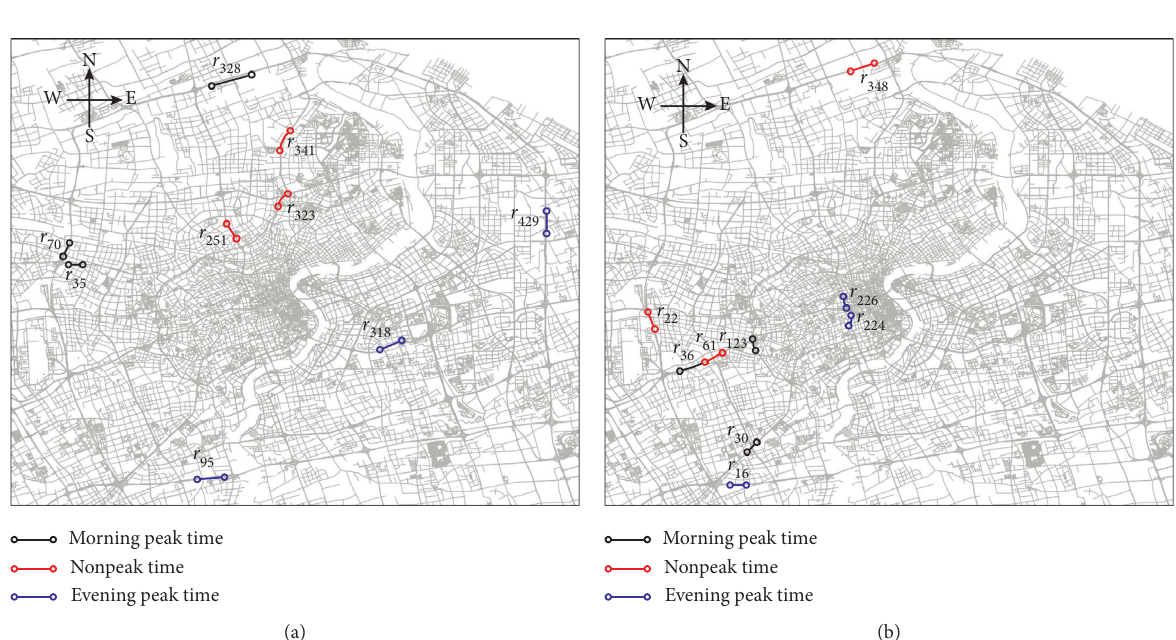
Figure 11: Spatial distribution of critical road segments: (a) potential bottleneck segments; (b) critical road segments.